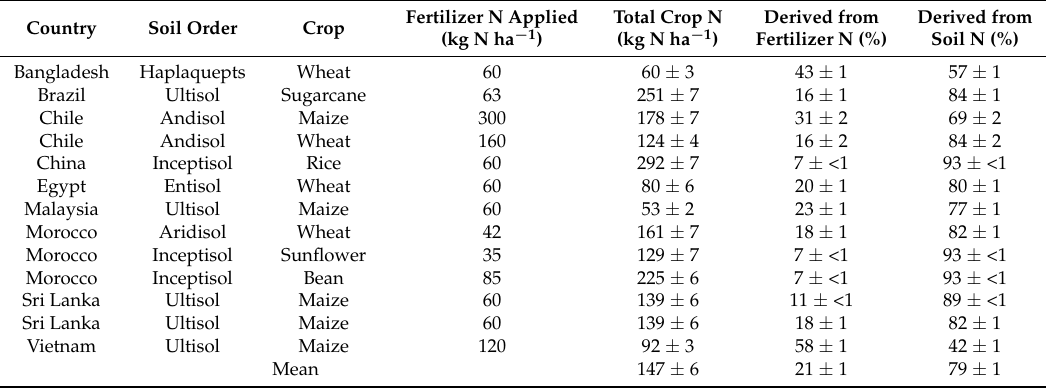
Fertilizer N Applied Total Crop N Derived from Derived from (kg N ha − 1 ) (kg N ha − 1 ) Fertilizer N (%) Soil N (%)